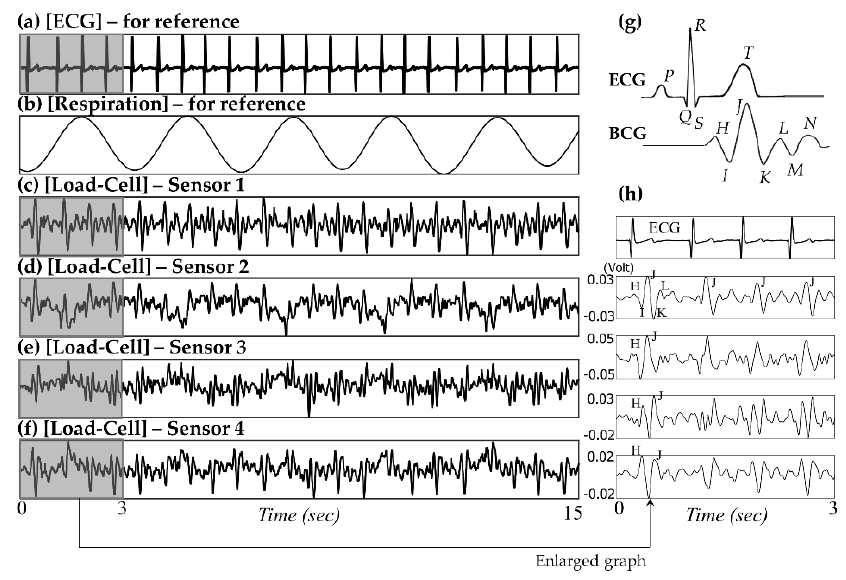
Figure 3. Simultaneous recordings of ( a ) ECG, ( b ) respiration signal, and ( d )–( f ) raw signals from four load-cell sensors, ( g ) typical BCG waveform (redrawn from literature [19]), and ( h ) waveform features of the BCG signal in our study.